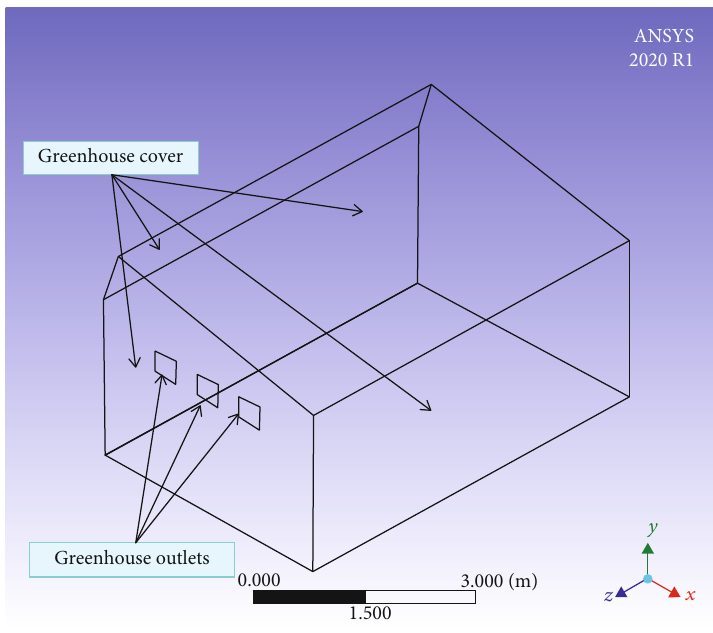
Figure 2: 3D geometric model of the uneven-span greenhouse